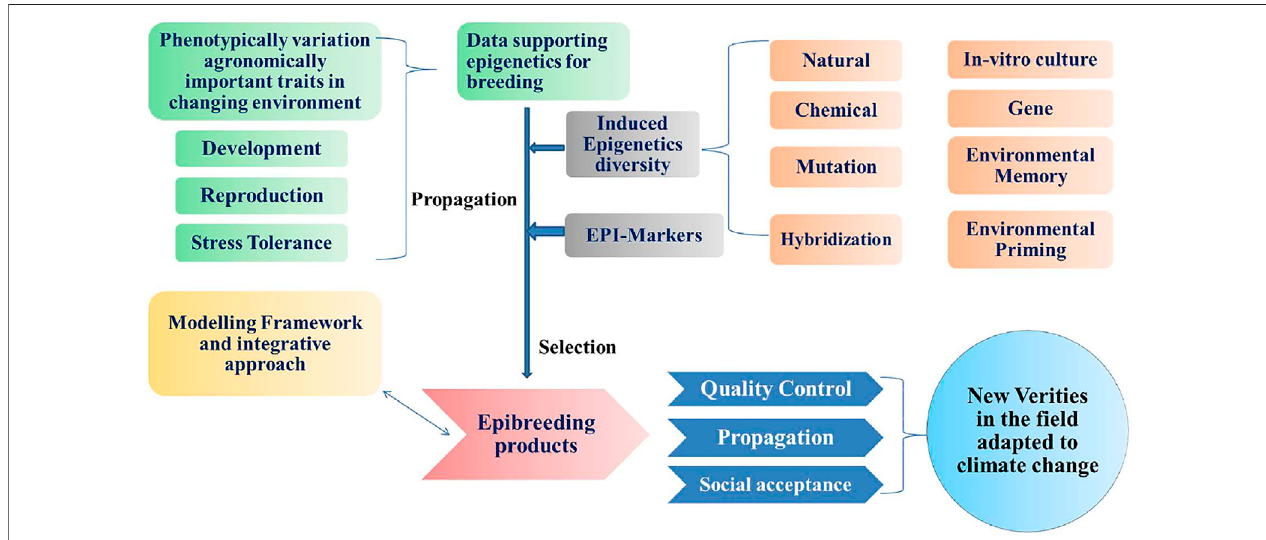
FIGURE 3 | Schematic integrated epigenetic data and tools will lead to epi-bred crops and new varieties in the fi eld adapted to climate change (Modi fi ed from Kakoulidou et al., 2021).